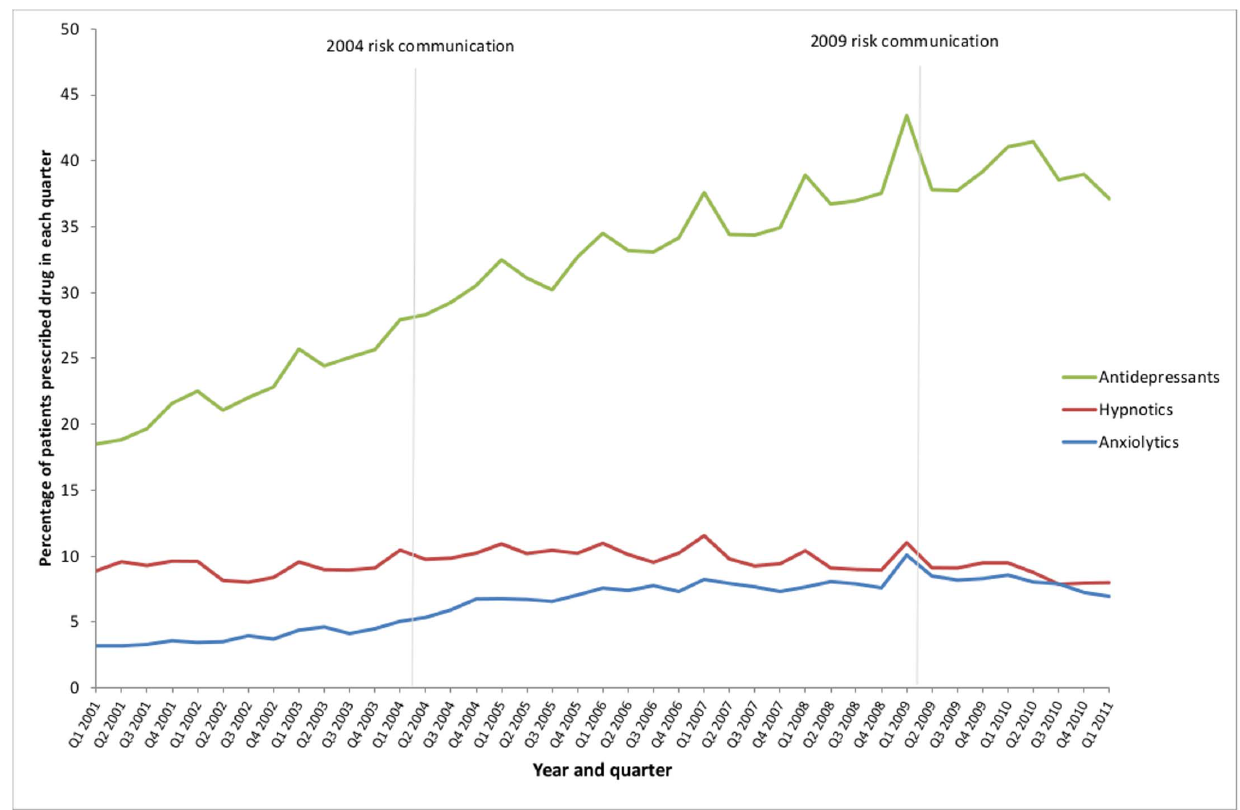
Figure 4. Hypnotic, anxiolytic and antidepressant prescribing in people aged $ 65 years with dementia.